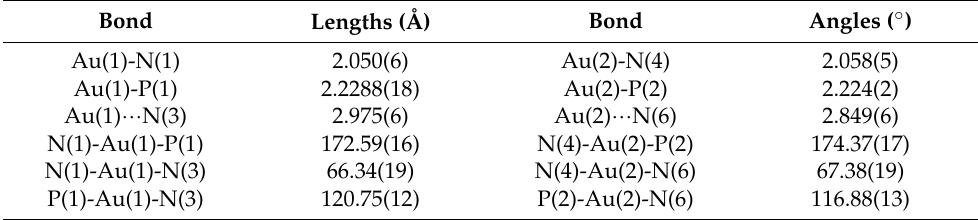
Table 2. Selected bond lengths (Å) and angles ( ◦ ) for 2 .